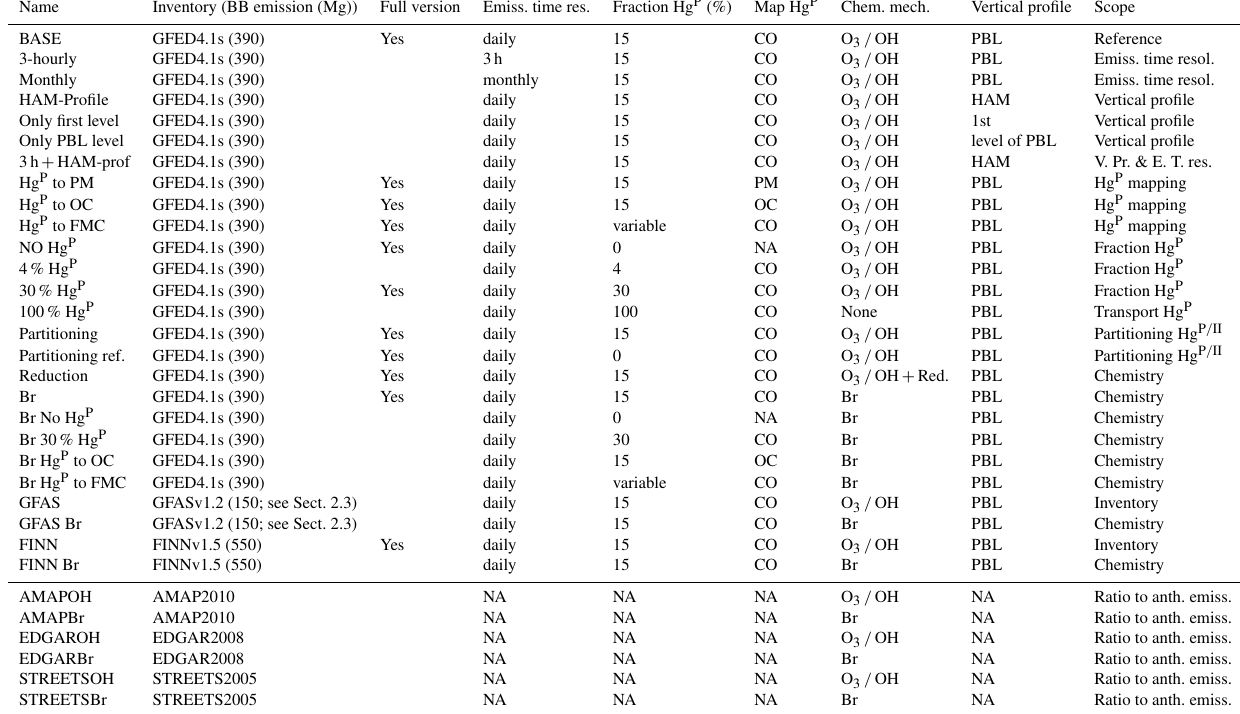
Table 1. Simulations